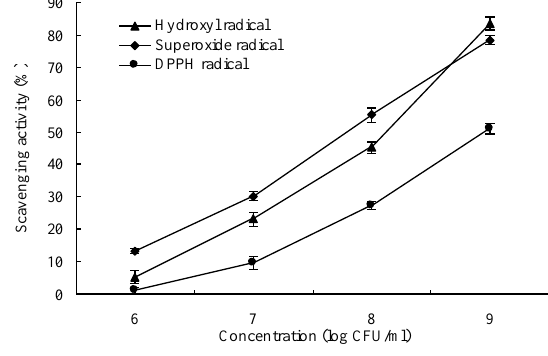
Figure 2. Scavenging activities of Lactobacillus plantarum ZLP001 on hydroxyl radical, superoxide radical, and 1,1- diphenyl-2-picrylhydrazyl (DPPH) radical. Error bars indicate the standard deviation of three